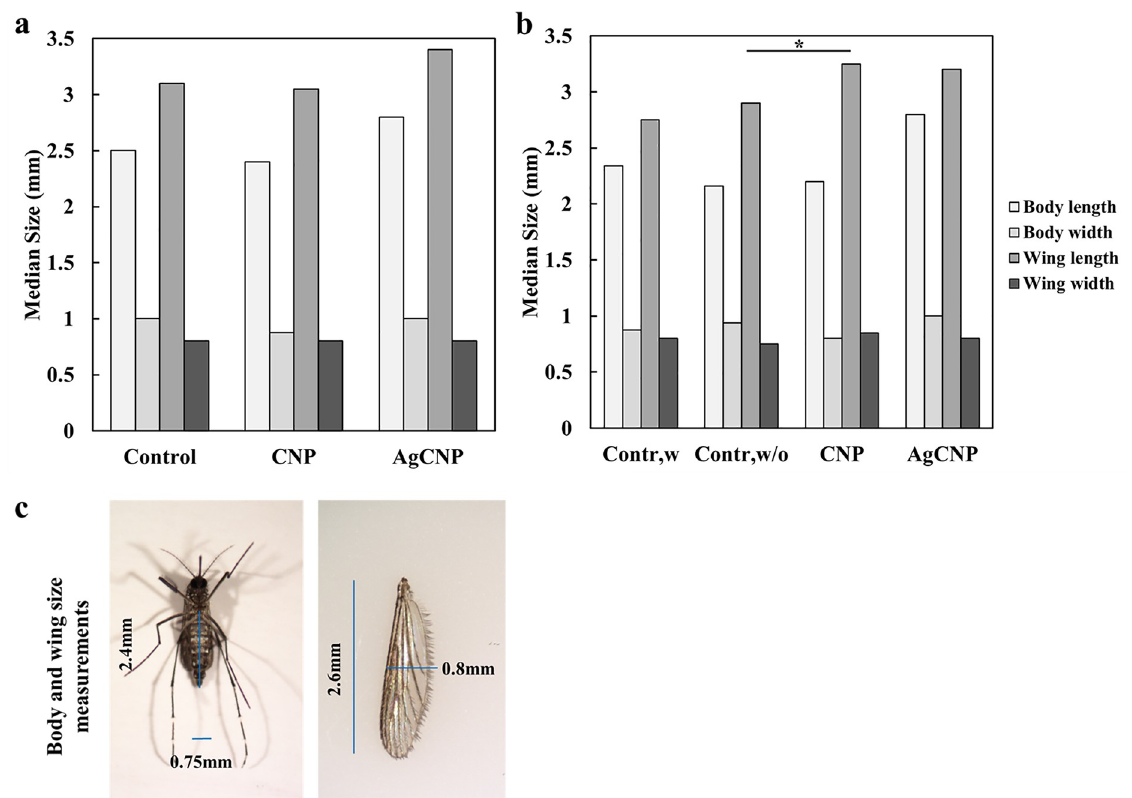
Fig 9. Effects on progeny life history traits of nanoparticle-treated Ae . aegypti larvae. Wing and body measurements of female progeny from eggs of mosquitoes treated with nanoceria in the 3 rd instar larval stage ( Fig 8 ) were analyzed to assess nanoceria effects on life history traits. ( a ) Median body and wing measurements of female progeny when larval food was present during nanoparticle exposure ( Fig 8B ); all measurements in all groups were not significantly different. ( b ) Median body and wing measurements of female progeny when larval food was withheld for 48h during nanoparticle exposure ( Fig 8D ). All measurements in all groups of this experiment were not significantly different except for the median wing length of the CNP-treated group, which was larger than the corresponding control food-withheld group (p-value < 0.05). ( c ) Representative images of a mosquito and wing overlaid with blue lines indicating corresponding body and wing measurements. Contr,w: control, larval food present; Contr,w/o: control, larval food withheld. � : p-value < 0.05. Solid line in ( b ) indicates a significantly different comparison between the medians of wing length between groups. Experiments for ( a ) were repeated twice with three (3) cups of mosquitoes each, yielding six (6) cups in total for each experimental condition. Experiments for ( b ) were repeated three (3) times with two (2) cups of mosquitoes each, yielding six (6) cups in total for each experimental condition.